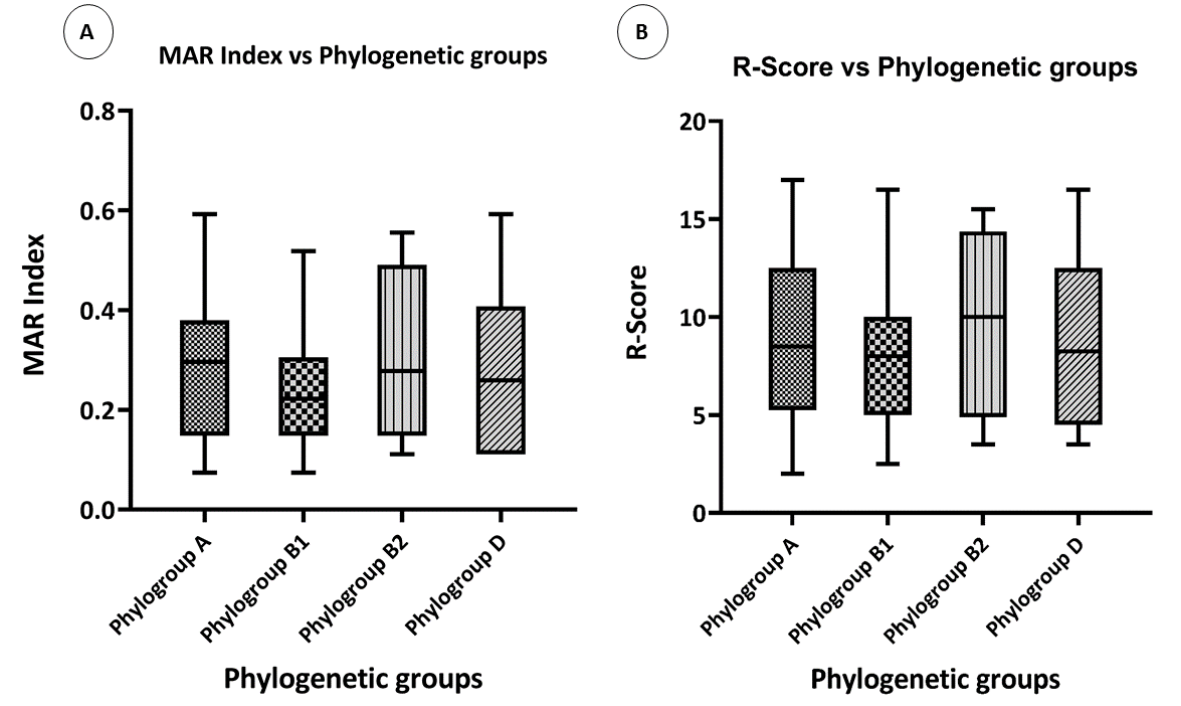
Figure 6. Phenotypic associations: ( A ) box plot showing the comparison of the MAR indexes of various phylogenetic groups, and ( B ) box plot showing the comparison of the R-Scores of various phylogenetic groups.